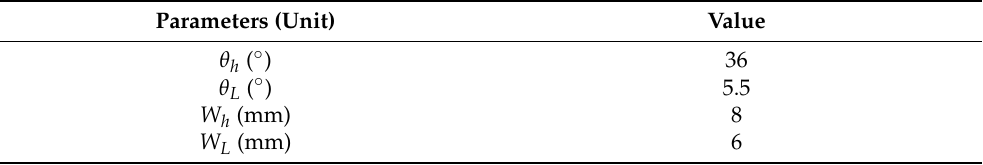
Table 4. Rotor parameters of the final type of design.